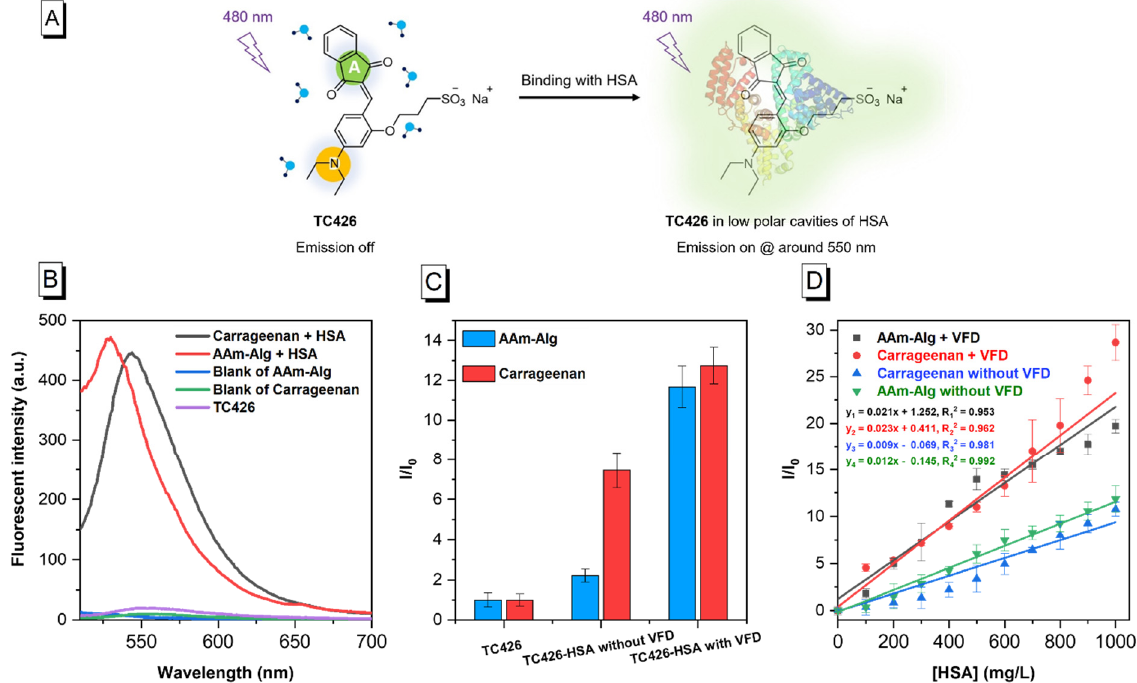
Figure 2. Characterisation of hydrogel films using TC426. ( A ) Schematic of the working mecha- nism of TC426 in HSA detection [12]; ( B ) FL spectra of TC426 in two matrices: AAm − Alg and carrageenan under different conditions; ( C ) effect of TC426-based hydrogel films with and without VFD modulation; ( D ) standard curve of TC426-embedded hydrogel films under different HSA concentrations ranging from 0 to 1000 mg/L with/without VFD processing. TC426 = 10 μ M, λ ex = 480 nm, I 0 = intensity of HSA = 0 mg/L; VFD was used for 2 and 4 min in AAm–Alg + TC426 and Carrageenan + TC426, respectively.